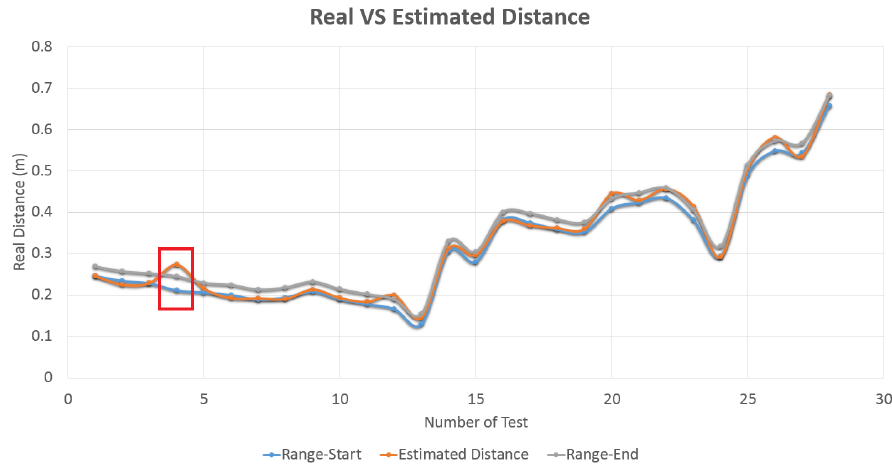
Figure 16. Confidence test. Grey and blue lines represent the current distance range. Orange line is the estimation. Red box shows the only one error over 1 cm.